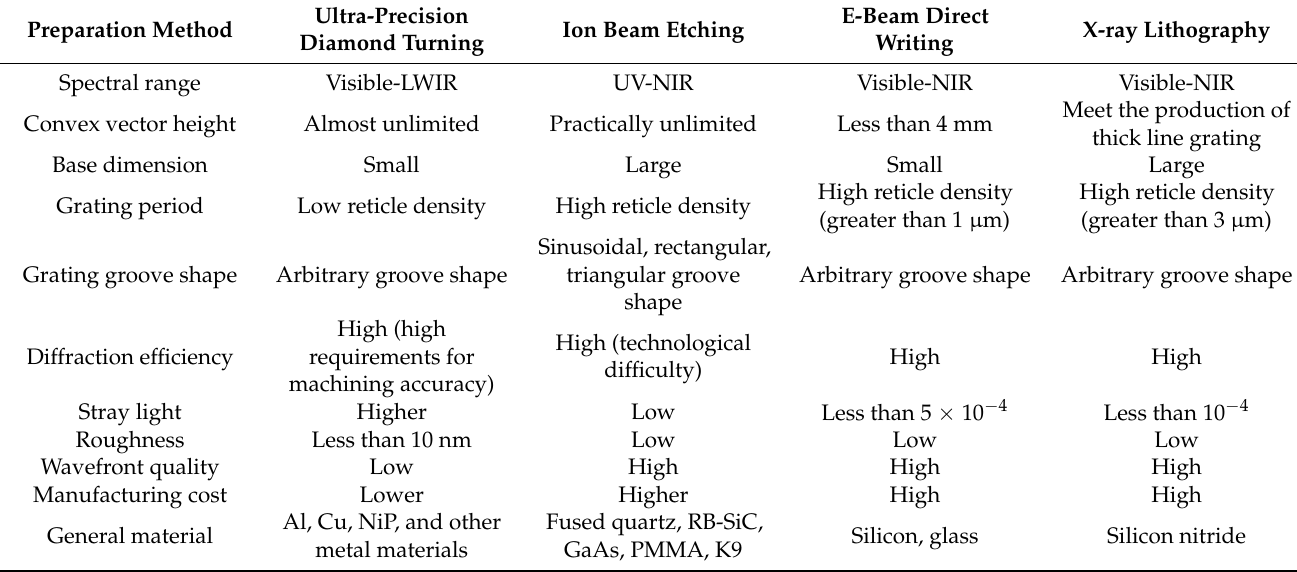
Table 1. Comparison of several common fabrication methods for convex gratings.